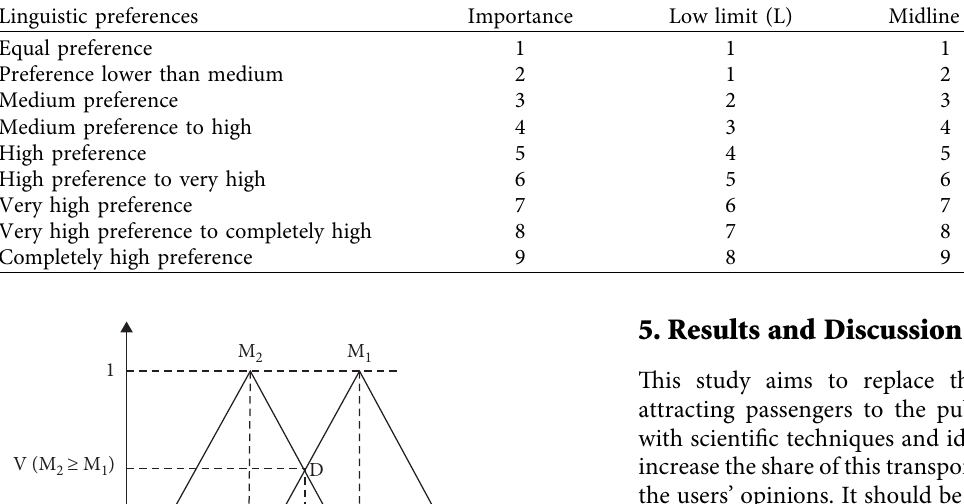
Table 2: Fuzzy spectrum corresponding to linguistic preferences.